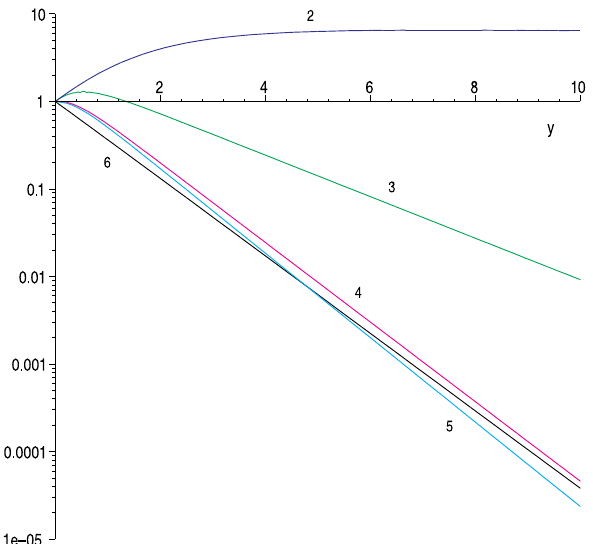
Fig. 5 Full propagators for different values μ and λ as functions of y . (2) μ = 1, λ = 1 / 3; (3) μ = 1, λ = 1; (4) μ = 0 . 1, λ = 1; (5) μ = 0, λ = 1; (6) μ = − 1, λ = 0 . 1